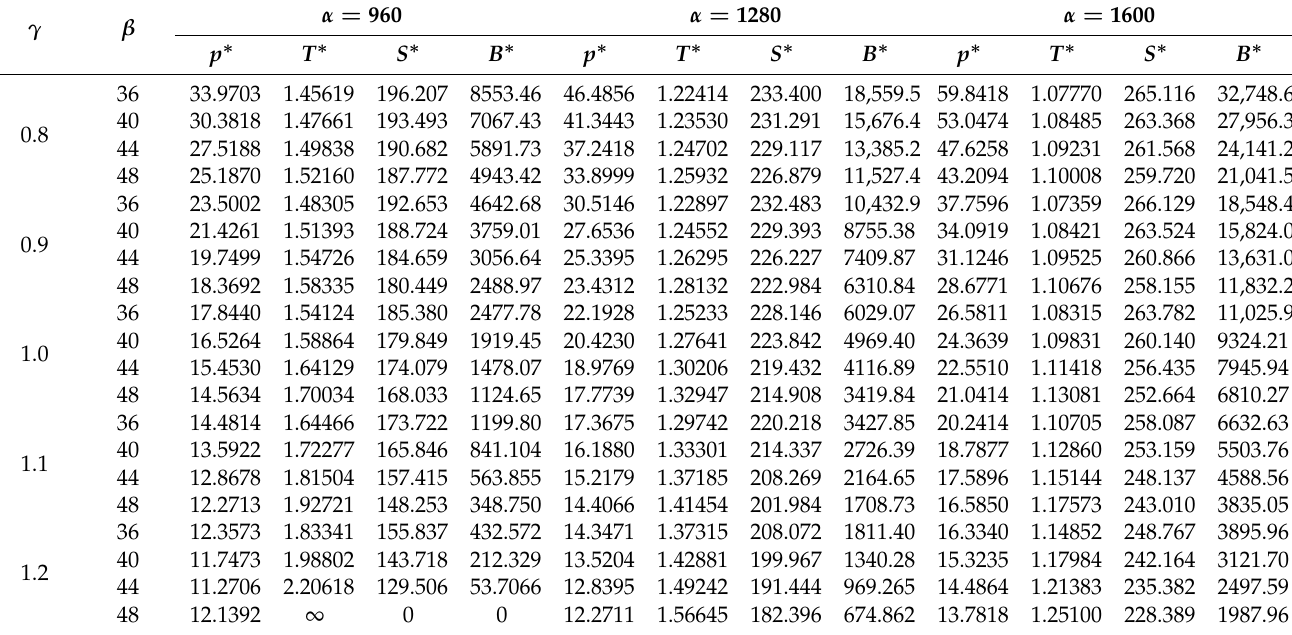
Table 2. Sensitivity of the optimal policy ( p ∗ , T ∗ , S ∗ ) and the maximum profit B ∗ to variations of the parameters α , β and γ when n =